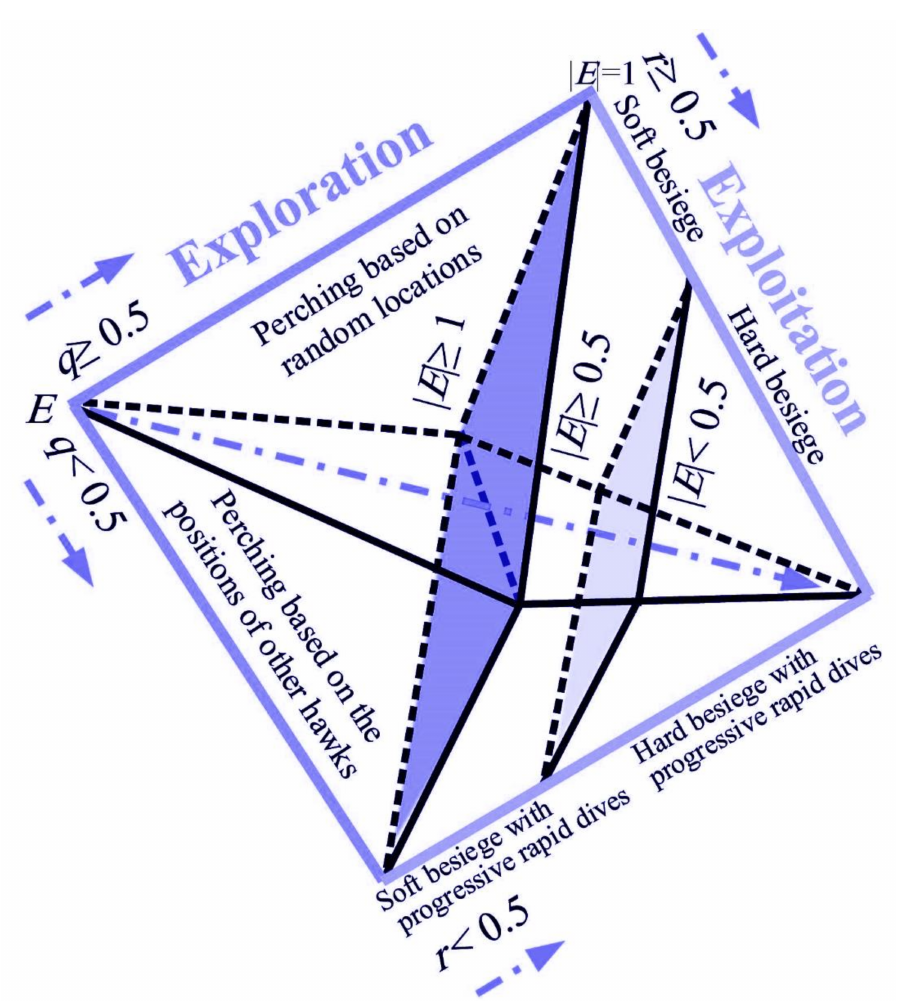
Figure 2. The main stages of Harris hawks optimization